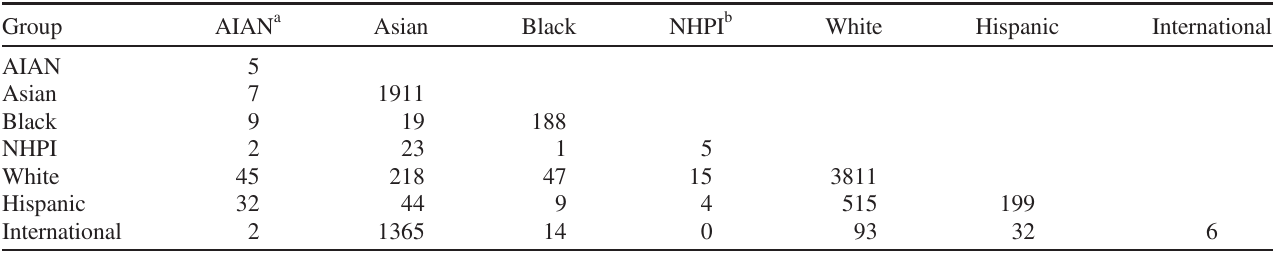
TABLE III. Student intersectionality. Numbers on the diagonal represent students who reported only one category. Values do not add up to the total number of students because some students reported belonging to more than two groups.